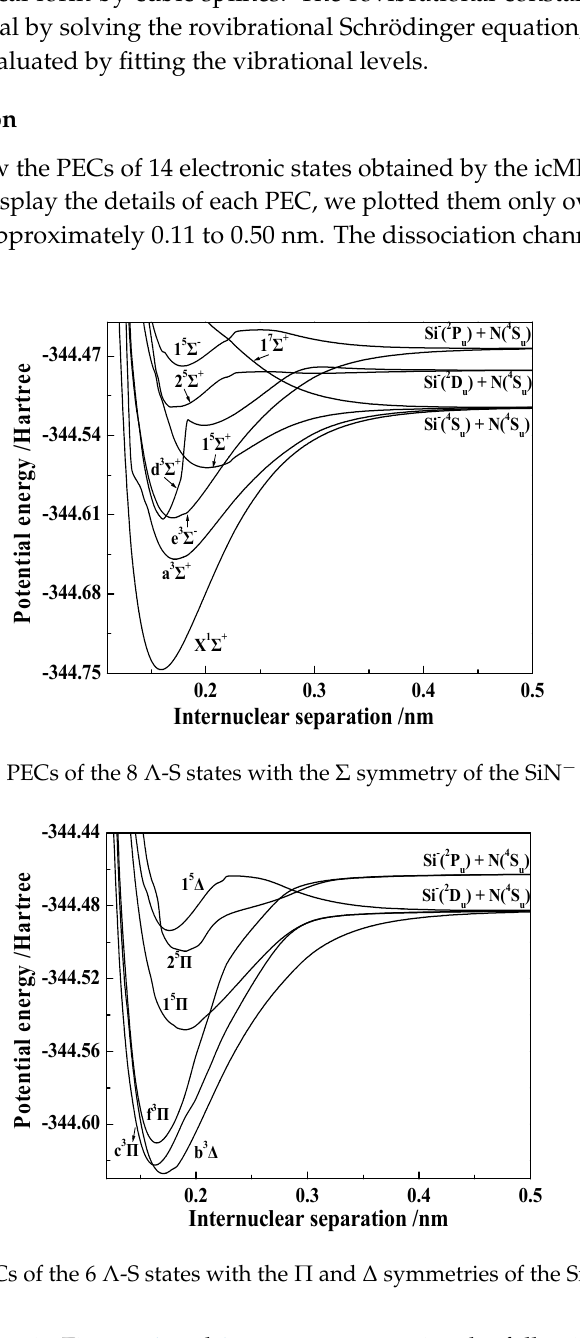
Figure 2. PECs of the 6 Λ -S states with the Π and Δ symmetries of the SiN − anion.